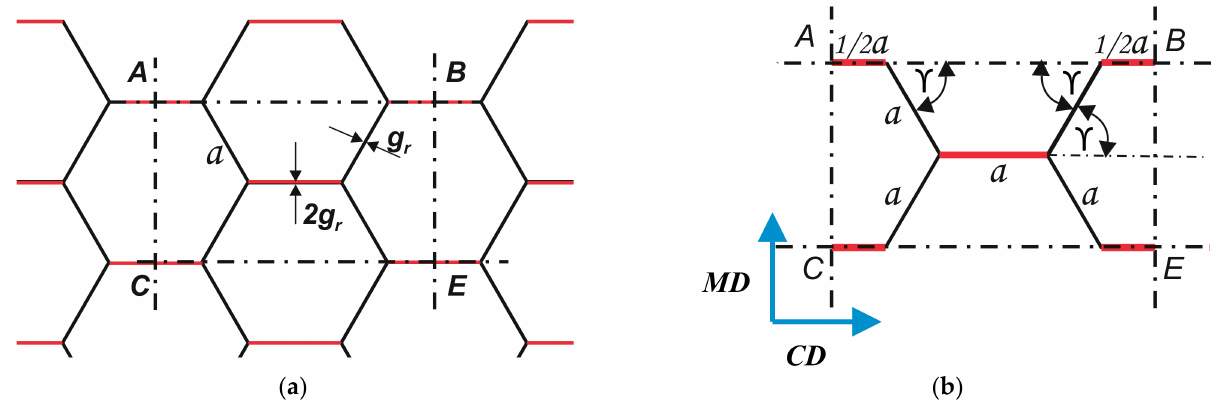
Figure 6. Periodic cells: ABCE —periodic cell separated from the paperboard core ( a ); dimensions of the periodic core cell ( b